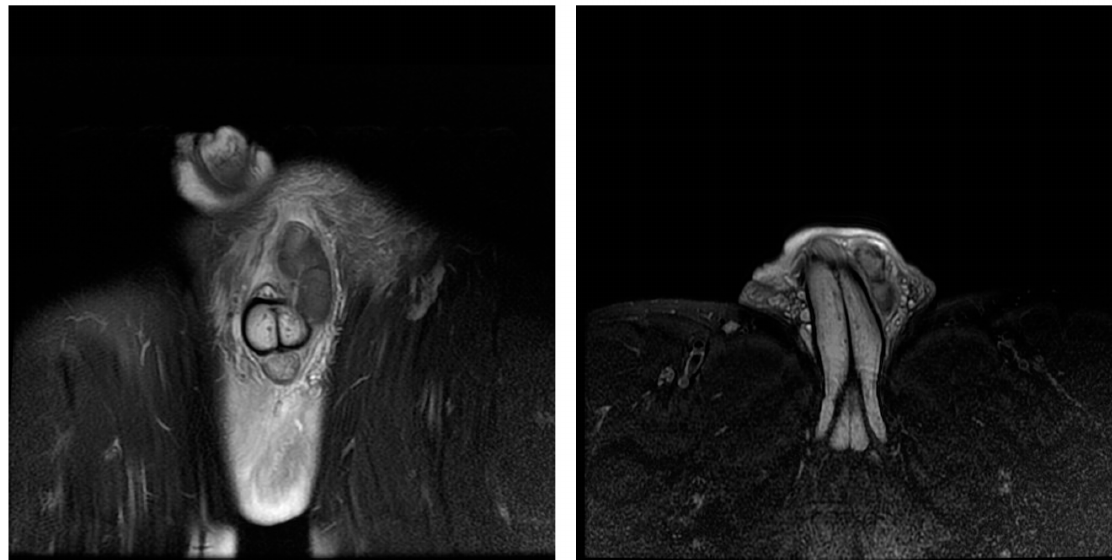
Fig. 3. MRI Finding of Penile Fracture. Adapted from Ory et al . [15]. Copyright CUA. Reprinted with permission. 5 mm defect of left tunica albuginea and overlying hematoma on 1.5T MRI